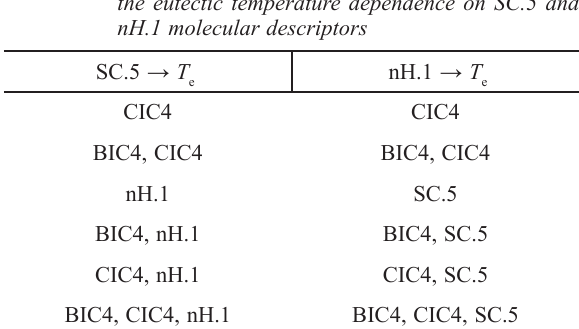
Table 3 – Adjustment Z sets for the causal determination of the eutectic temperature dependence on SC.5